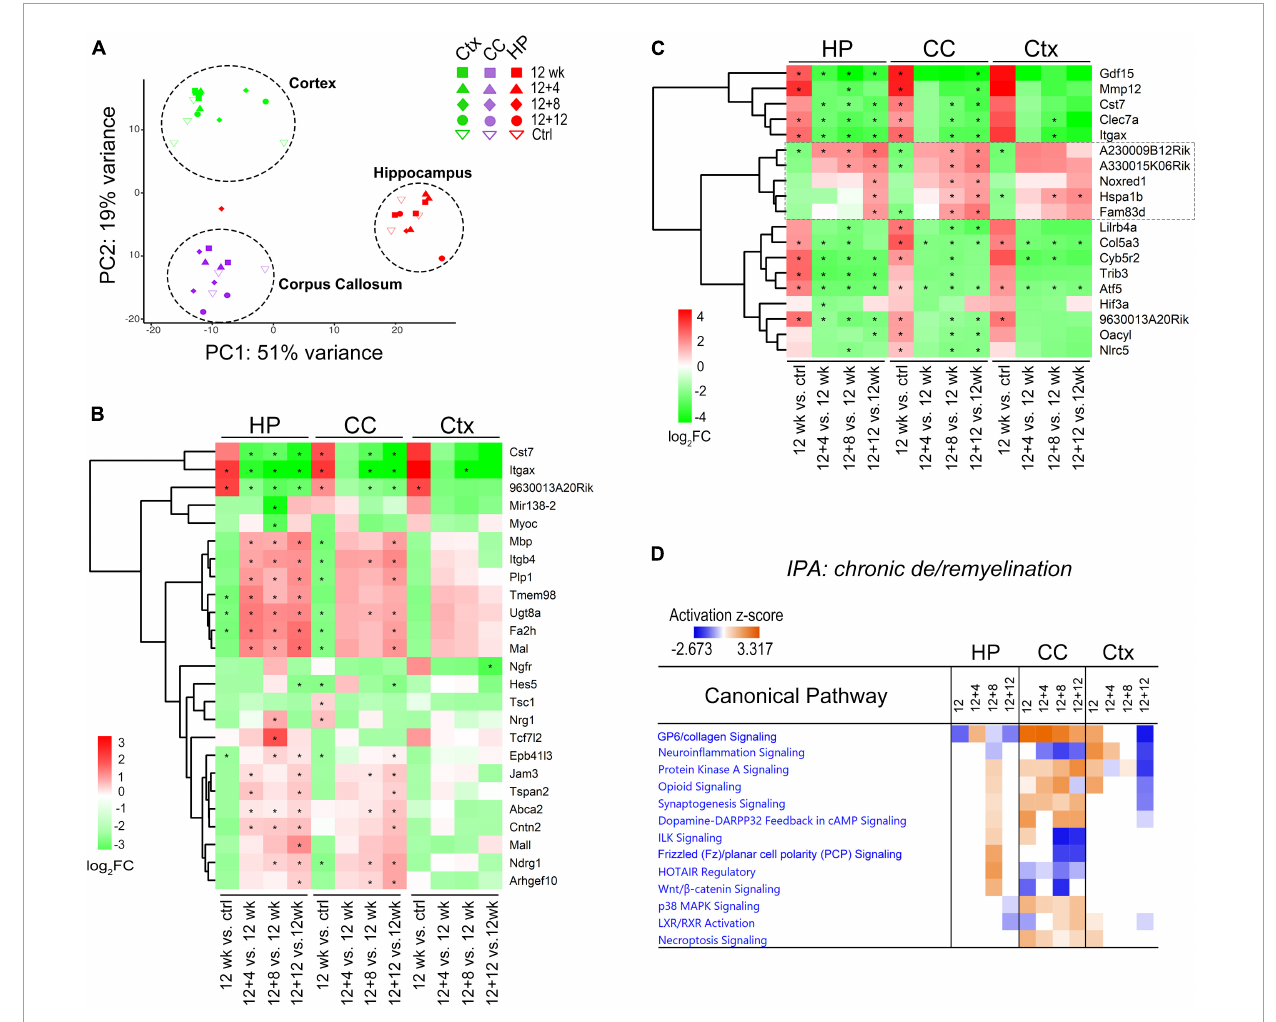
FIGURE4 Comparative transcriptome analysis reveals brain-region dependent changes of canonical pathways during chronic de/remyelination. (A) Principal component analysis (PCA) of gene expression shows the separation of three sample groups corresponding to the brain regions: hippocampus (HP), corpus callosum (CC), and cortex (Ctx). Each dot represents an individual sample. (B) Relative expression changes of myelination related genes (GO0042552, 171 genes, q < 0.05) during recovery phase after chronic demyelination. A Heatmap of the top 25 highly modulated genes (ranked) is shown. Asterisks indicate q < 0.05. (C) Heatmap of 19 DEGs commonly modulated across the three brain regions (HP, CC, and Ctx). Asterisks indicate q < 0.05. (D) IPA comparison analysis across regions and time-points revealed specific canonical pathways activated in the corpus callosum. Positive (orange) and negative (blue) z-scores indicate predicted, respectively, activation and inhibition of specific pathways. Values of |z| > 2 are considered highly